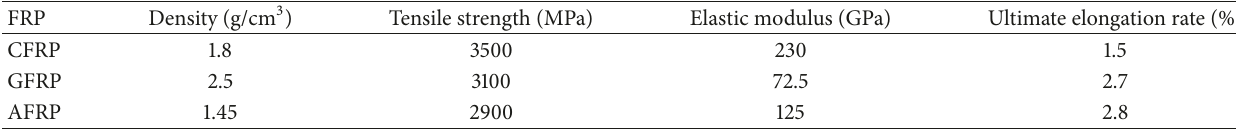
Table 7: Main physical parameters of CFRP, GFRP, and AFRP.